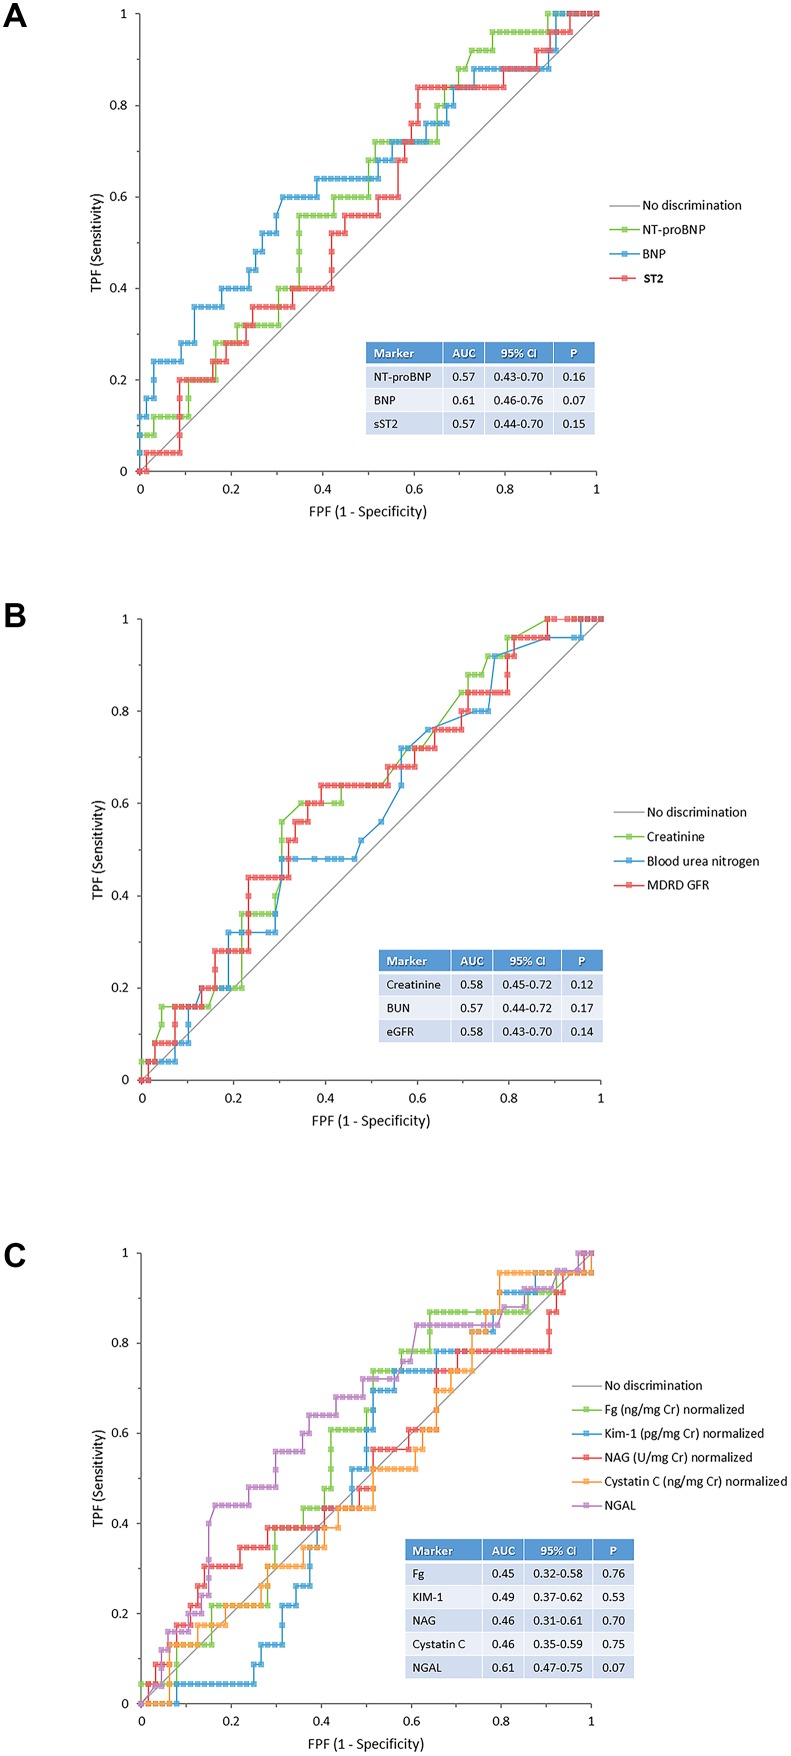
Receiver operating curve of biomarkers of cardiac stretch (1A), renal function (1B) and renal injury (1C).